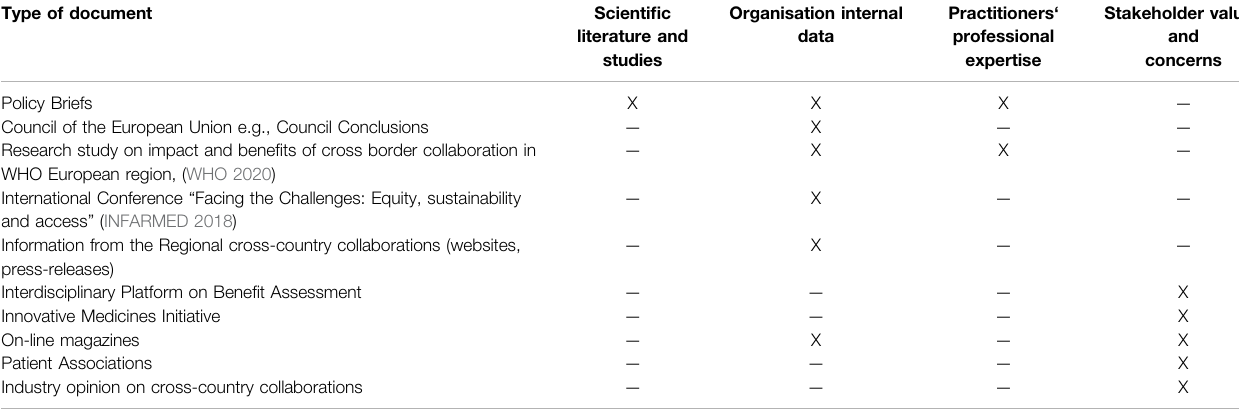
TABLE 7 | Different types of documents used as grey literature and the sources of evidence